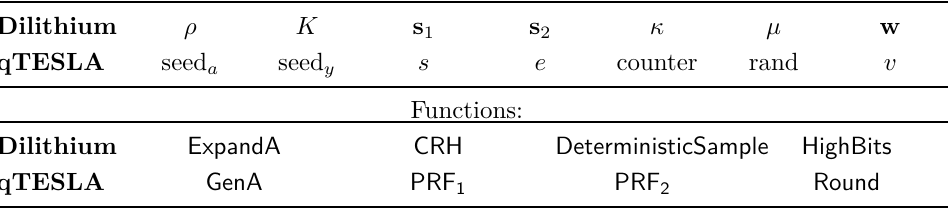
Table 8: Comparison of variable/parameter names and function names for Dilithium and qTESLA. Only differing names are